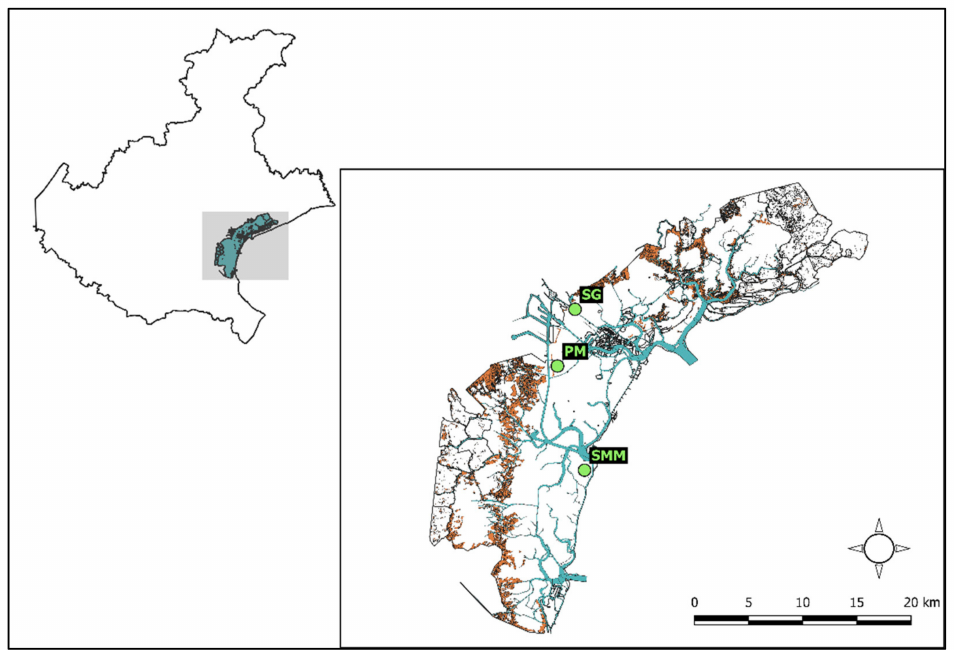
Figure 1. Sampling sites from the Venice Lagoon: SMM—Santa Maria del Mare; PM—Porto Marghera; SG—San